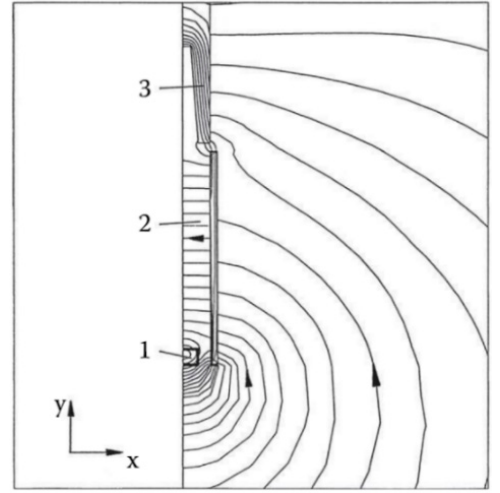
Figure 5. Increase of magnetic blow-out force by ferromagnetic side plates: 1—arc; 2—ferromagnetic side plates; 3—ferromagnetic plates [2].